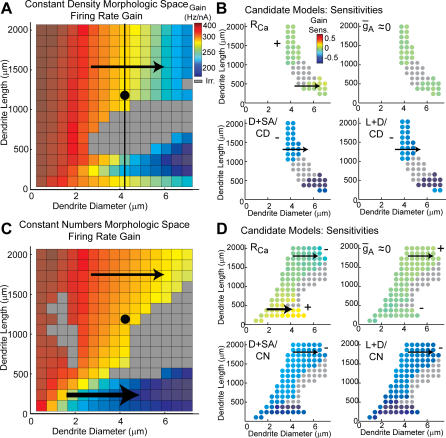
Firing Rate Gain Sensitivity Across Constant Density and Constant Numbers Morphologic Spaces(A) Colormap representing baseline firing rate gain across CD morphologic space (colorscale 0–400 Hz/nA; top right); the gain of models firing irregularly at 300 or 600 pA was not calculated (gray cells). Black vertical line denotes models with the default value of D; arrow indicates that D was the main driver of baseline gain.(B) Gain sensitivity to RCa and
(top row) and to D + SA / CD and L + D / CD (bottom row). Models shown in gray fired irregularly. Arrows indicate the principal sensitivity direction with increasing D. Sensitivity to
was near zero throughout the space. Analogous colormaps across CN morphologic space are shown for (C) baseline firing rate gain and (D) gain sensitivity to parameter perturbations among candidate models. Arrows in (C) show that decreases in baseline gain followed D; the principal sensitivity directions in (D) follow this trend. Across constant number space, sensitivities to active parameters often had opposite sign for large versus small L values (“−” versus “+” in [D]). Among the candidate models, gain was more sensitive to D + SA than to all active parameters except
and sometimes
.